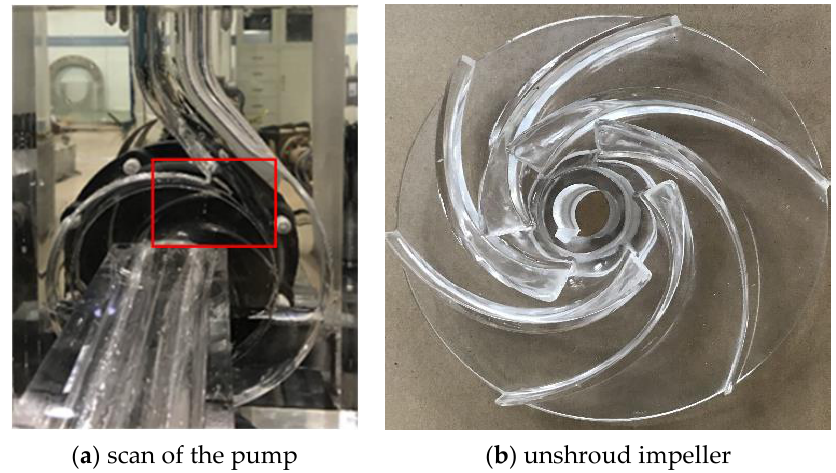
Figure 1. Plexiglass pump model.